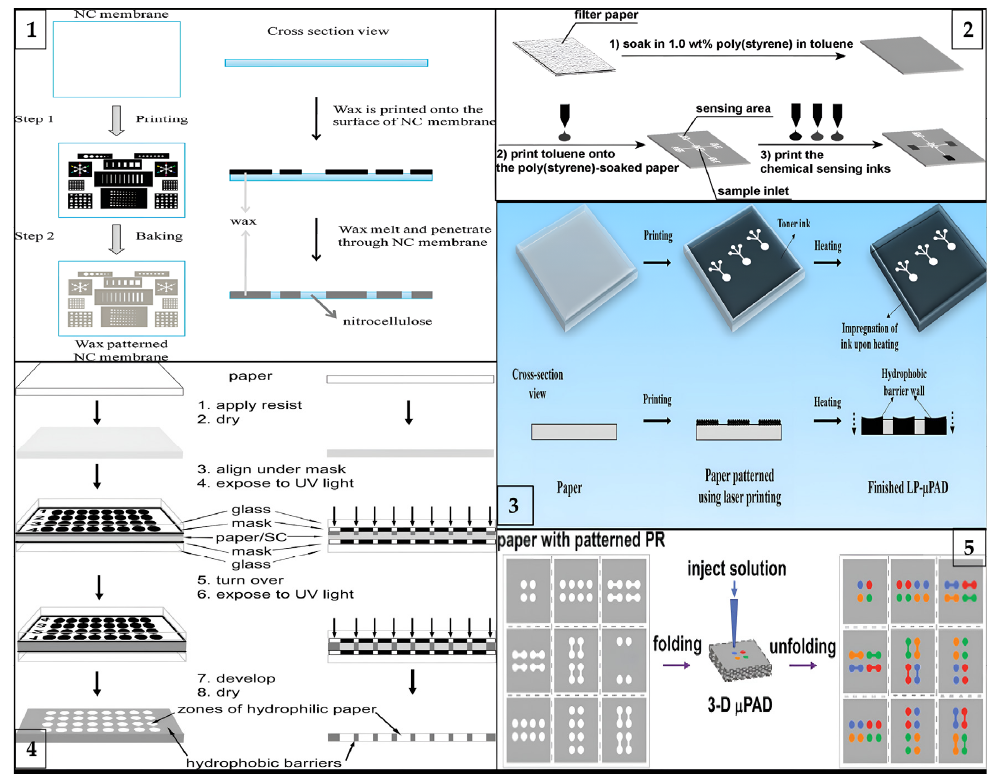
Figure 2. Schematic illustration of di ff erent types of fabrication processes for µPADs: ( 1 ) laser printing method (reprinted with permission from [41]; copyright 2019, Springer Nature); ( 2 ) wax printing method (reprinted with permission from [76]; copyright 2010, American Chemical Society); ( 3 ) photolithography method (reprinted with permission from [77]; copyright 2009, American Chemical Society); ( 4 ) three-dimensional origami method (reprinted with permission from [66]; copyright 2011, American Chemical Society); and ( 5 ) inkjet printing method (reprinted with permission from [36]; copyright 2008, American Chemical Society).